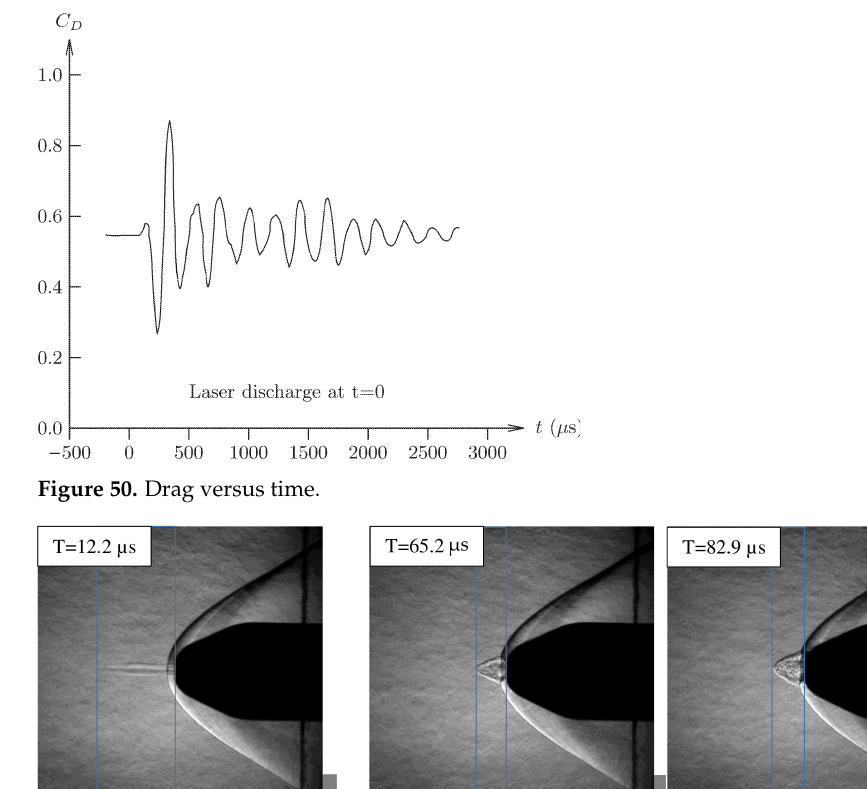
Figure 49. Flow configuration. Reprint from [96] with permission from ONERA.